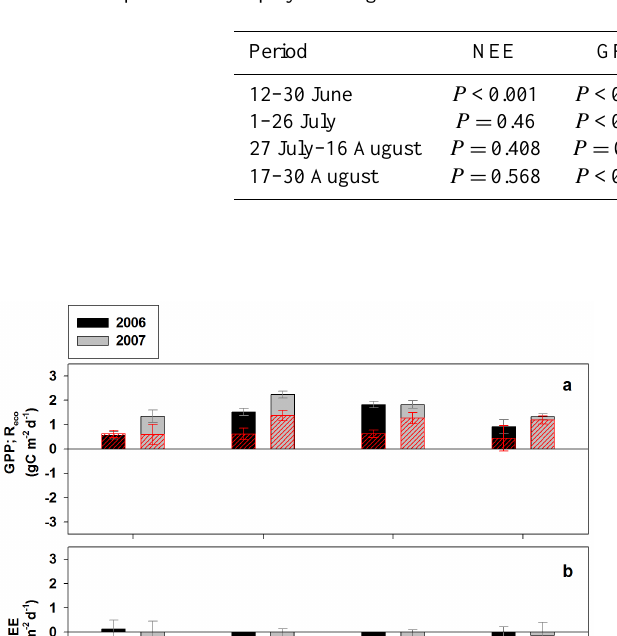
Table 2. Statistical results for the significance of the difference of net ecosystem exchange (NEE, F ratio = 44.8, d.f. = 7, 3788), gross pri- mary production (GPP, F ratio = 214, d.f. = 7, 7768), ecosystem respiration ( R eco , F ratio = 694.7, d.f. = 7, 7768), net Sphagnum exchange (NSE, F ratio = 2.96, d.f. = 7, 12), and leaf area index (LAI, F ratio = 1.5, d.f. = 5, 99), between 2006 and 2007 (one-way ANOVA including type III adjusted sums of squares, and Bonferroni post hoc test) for the indicate periods; NA indicates no data available. Descriptive data on the flux C components are displayed in Fig. 2.